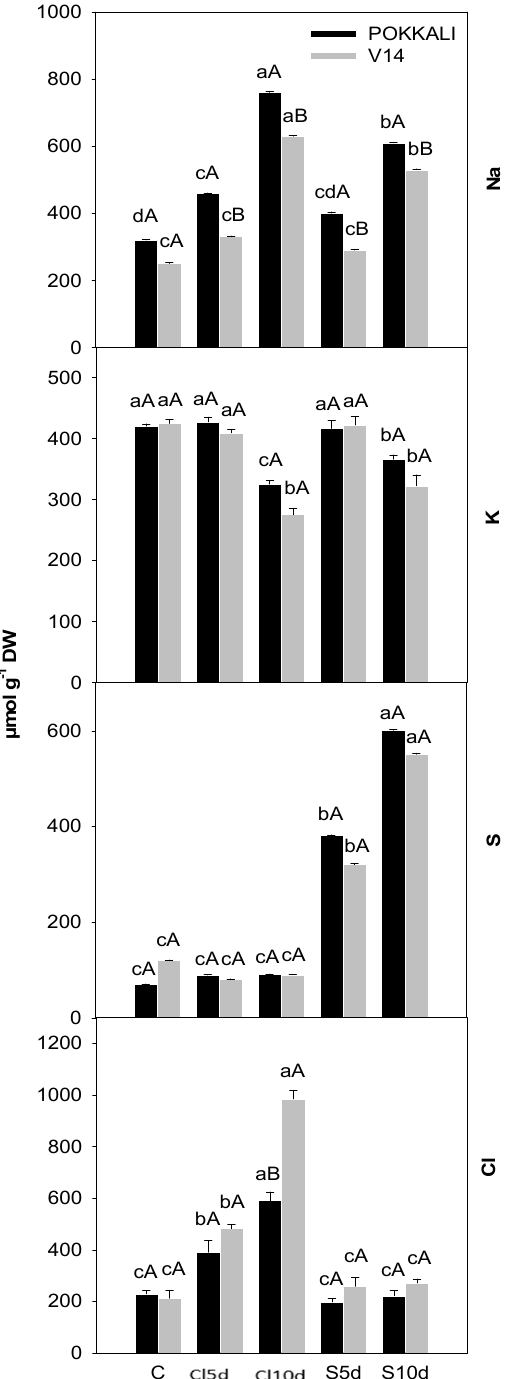
Figure 1. Mineral nutrients concentration in shoot of rice control plants (C) and plants stressed by 5 dS m − 1 (5d) or 10 dS m − 1 (10d) of NaCl (Cl) or Na 2 SO 4 (S). Plants belong to two cultivars (Pokkali: salt-resistant and V14: salt-sensitive). Each value is the mean of three replicates per treatment and vertical bars are standard errors of the mean. Treatments followed by the same lowercase letter for a particular cultivar do not differ statistically. Cultivars followed by the same uppercase letter in a particular treatment do not differ statistically.